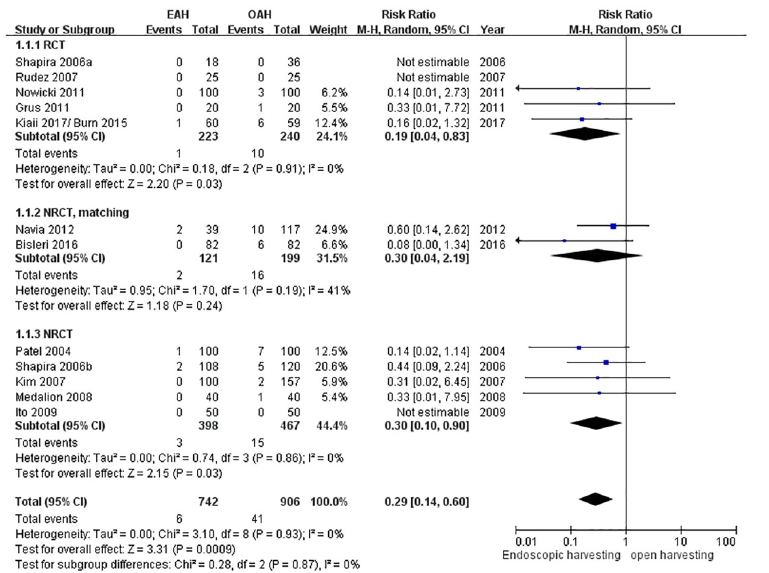
Fig 3. Forest plot for the wound infection rate.